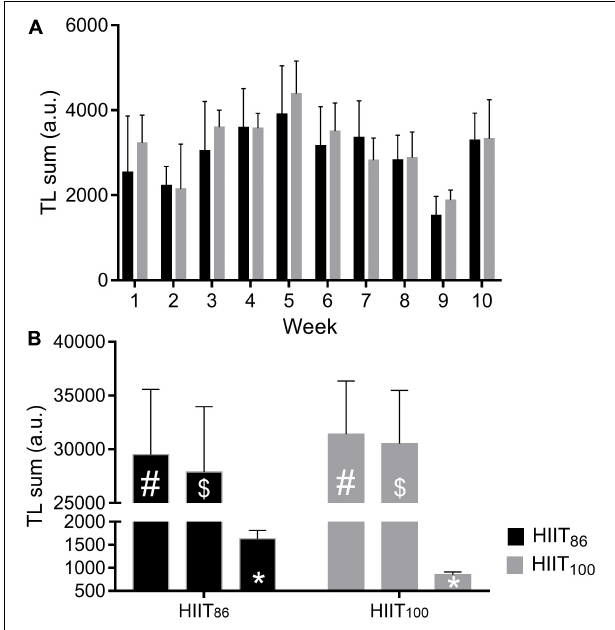
FIGURE 5 | Observed means ± SD of training load sum in each week (A) and the accumulated sum over 10 weeks of all training/match sessions [#], all training/match sessions without HIIT [$], and only HIIT sessions [*] (B) . Bars and error bars are the mean and SD, respectively. a.u., arbitrary